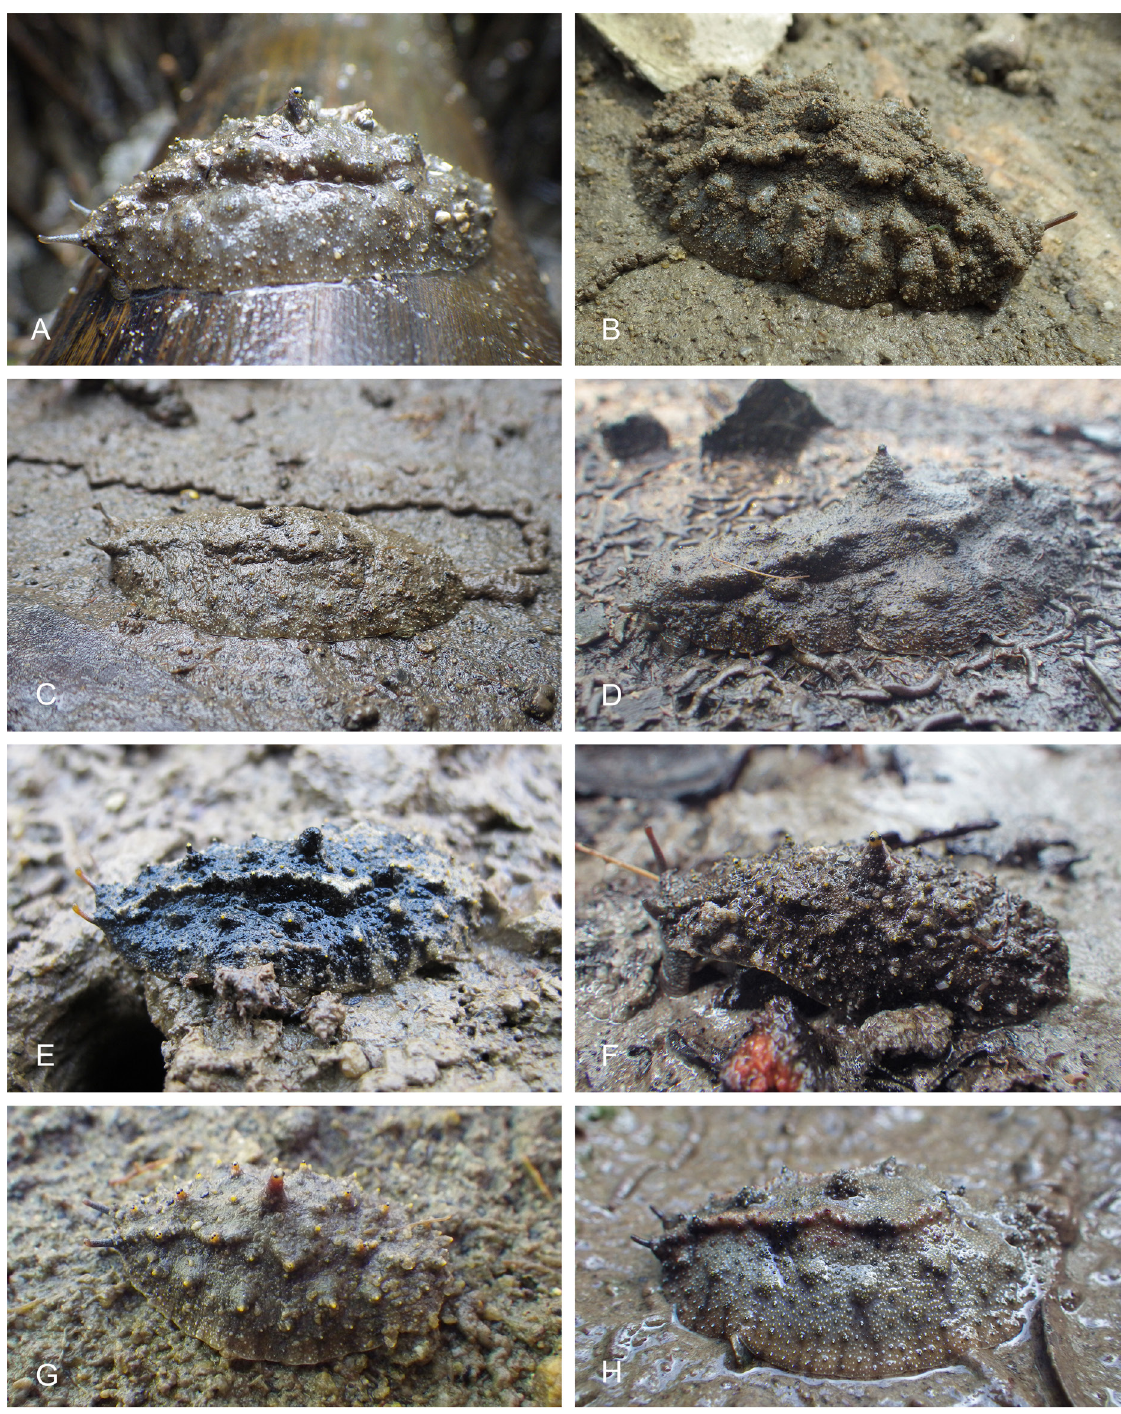
Fig. 7. Paromoionchis tumidus (Semper, 1880) comb. nov. unit #1, live animals. A . Dorsal view, 35 mm long [3205], Philippines, Luzon (PNM 041256). B . Dorsal view, 40 mm long [5682], Vietnam (ITBZC IM 00019). C . Dorsal view, 33 mm long [3222], Philippines, Luzon (PNM 041257). D . Dorsal view, 54 mm long [5042], Indonesia, Halmahera (UMIZ 00137). E . Dorsal view, 30 mm long [1705], Australia, Northern Territory (NTM P.57622). F . Dorsal view, 26 mm long [2875], Indonesia, Seram (UMIZ 00130). G . Dorsal view, 17 mm long [2627], Australia, Queensland (MTQ). H . Dorsal view, 27 mm long [1755], Indonesia, Sumatra (UMIZ